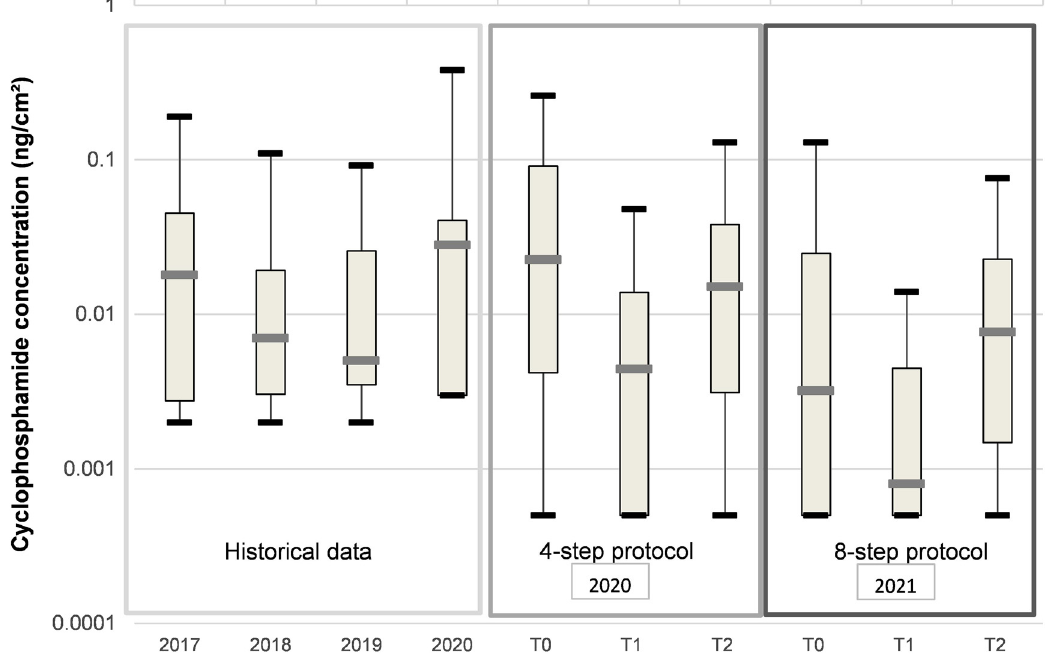
Figure 2: Cyclophosphamide contamination on floor in front of the biological safety cabinets (ng/cm 2 ) (n=8 sampling sites). 2017 – 2020 data obtained from historical surface monitoring results. The four-step decontamination protocol was conducted in 2020 and the eight-step protocol in 2021. Minimum, 25th, 50th, 75th percentile and maximum are shown. Logarithmic scale used. The limit of detection was 0.001 ng/cm 2